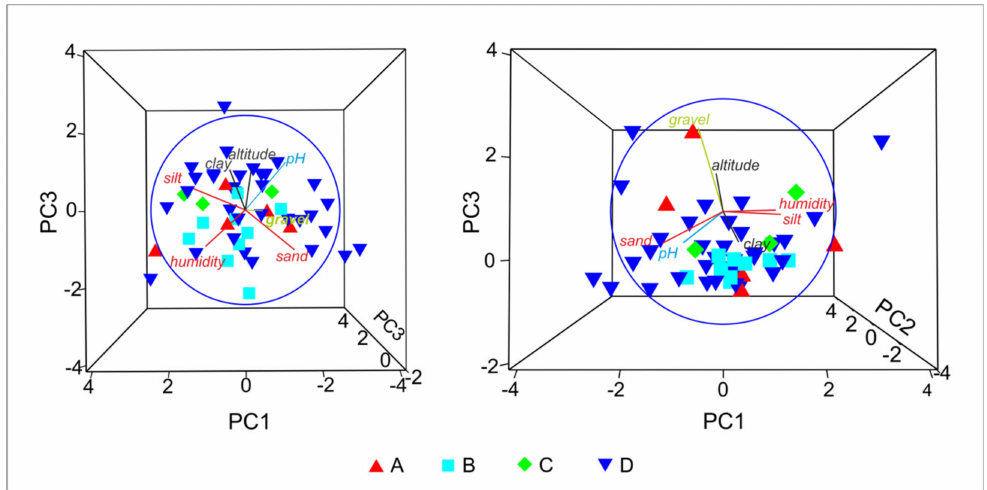
Figure 4. Results of principal component analysis (PCA) performed for the investigated study sites: A: sites with domination of Calomera lunulata , B: sites with domination of Grammognatha euphratica euphratica , C: sites with domination of Cicindela campestris atlantis , and D: sites with domination of Lophyra flexuosa flexuosa